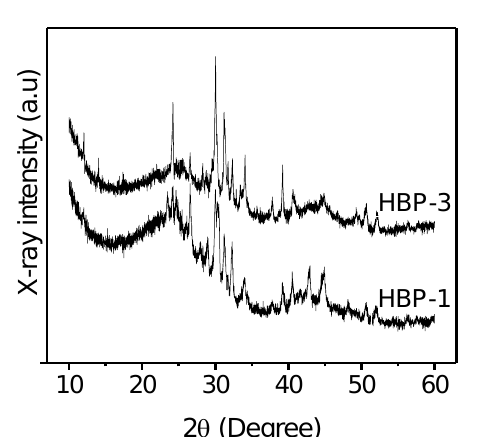
Fig. 4. XRD diffractogram of activated carbon monolith derived HBP-s samples